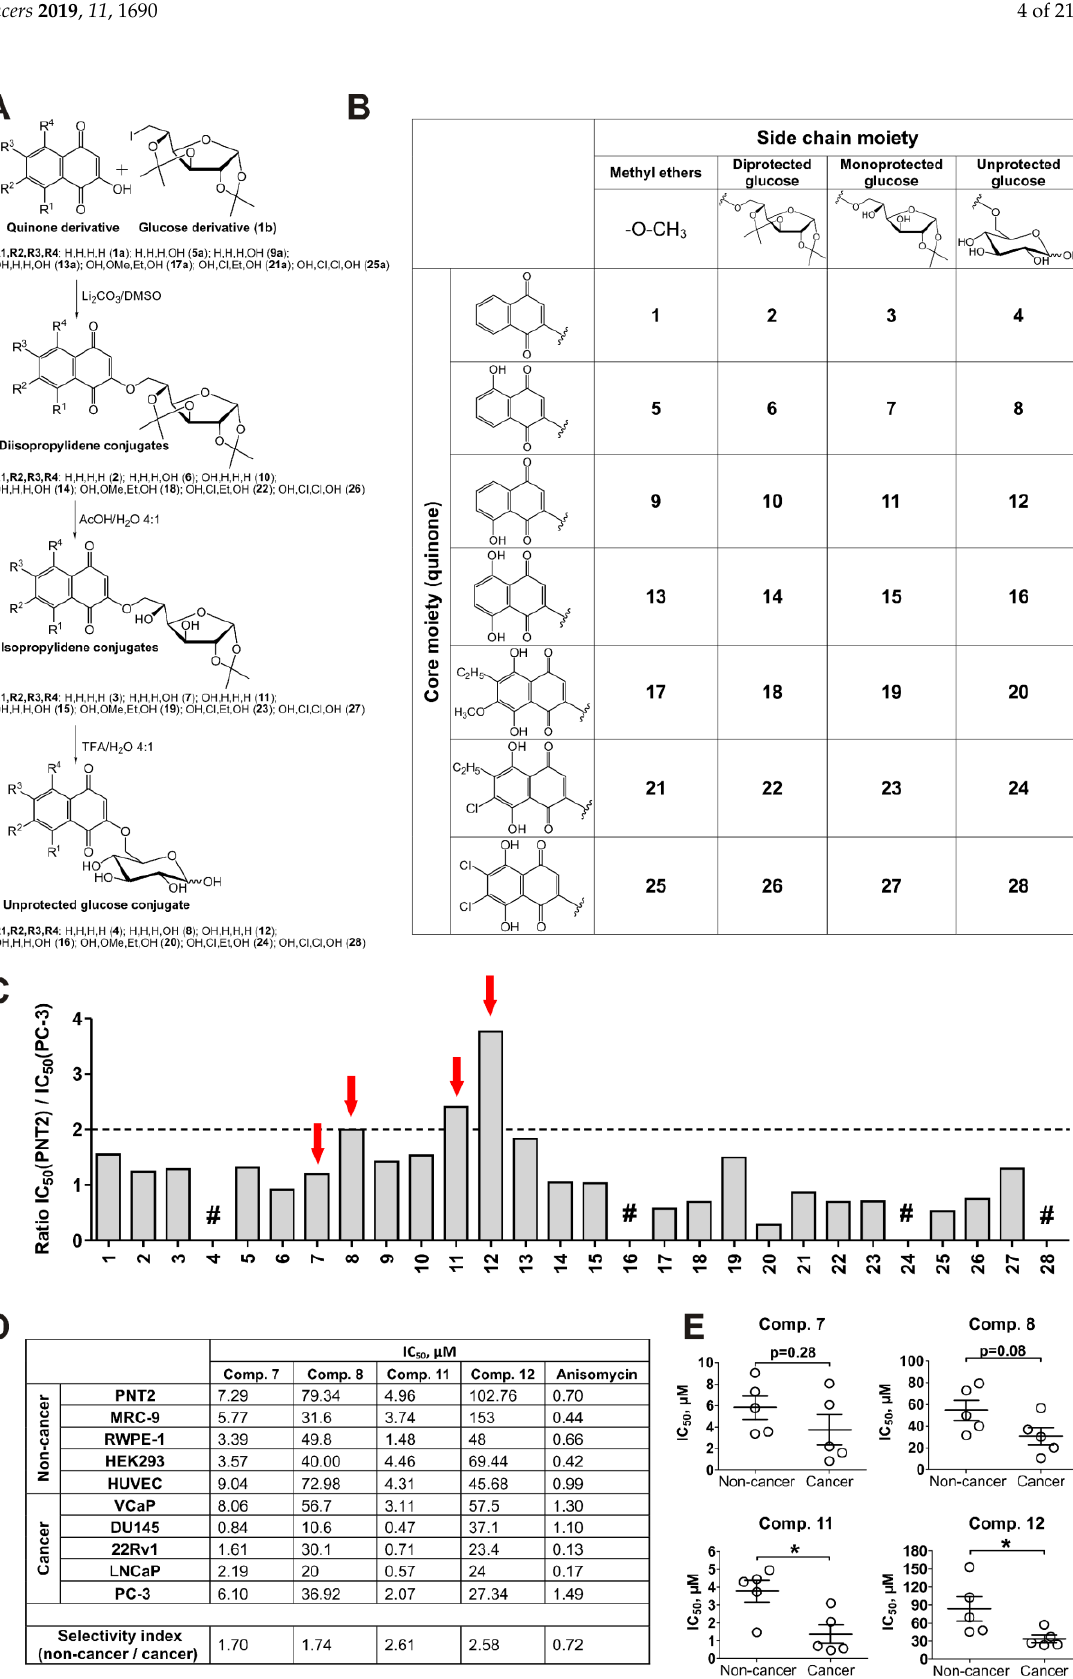
Figure 1. Cytotoxic activity of the synthesized compounds in cancer and non-cancer cells. ( A , B ) The scheme of the synthesis ( A ) and the structures ( B ) of the investigated conjugates. ( C ) Selectivity index values–the ratio of IC 50 in PNT2 cells to IC 50 in PC3 cells. “#”–IC 50 values towards the tested cell lines were >100 µM. The IC 50 s values are correspondent to those presented in Table S4. ( D , E ) The cytotoxicity profile of the compounds 7 , 8 , 11 , and 12 in prostate cancer and non-cancer cells. IC 50 s